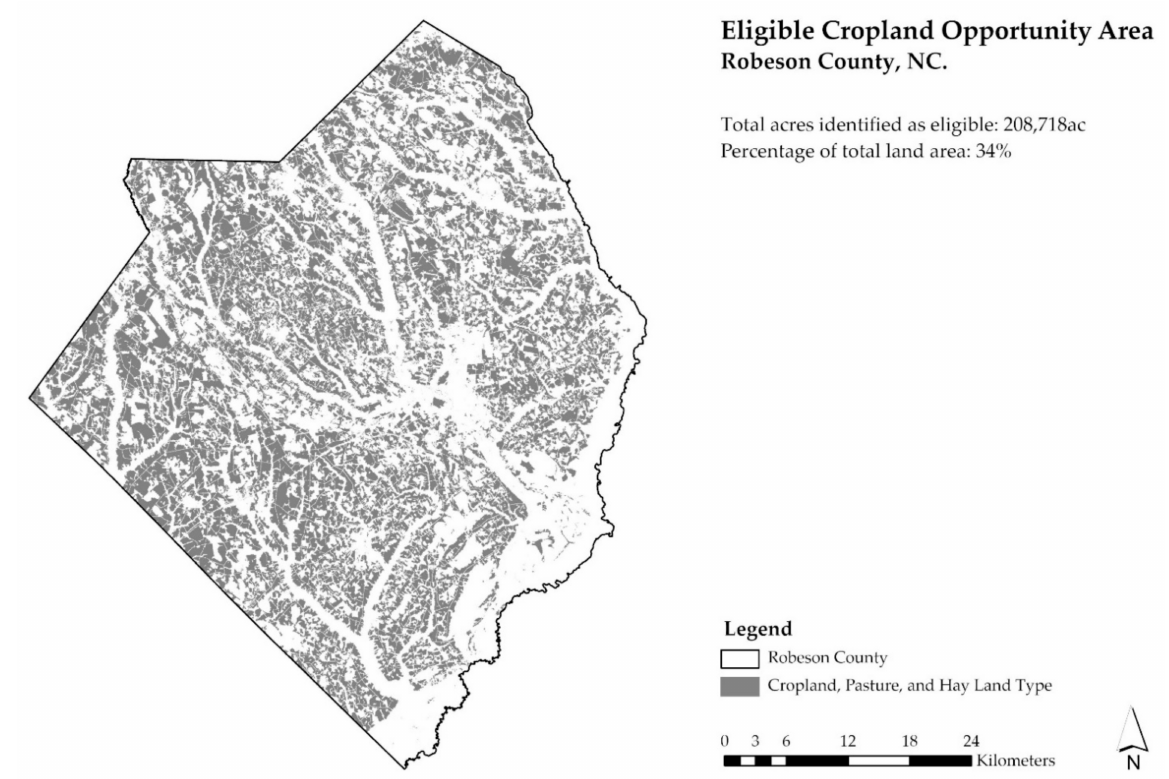
Figure 11. Area identified as Eligible Cropland in Robeson